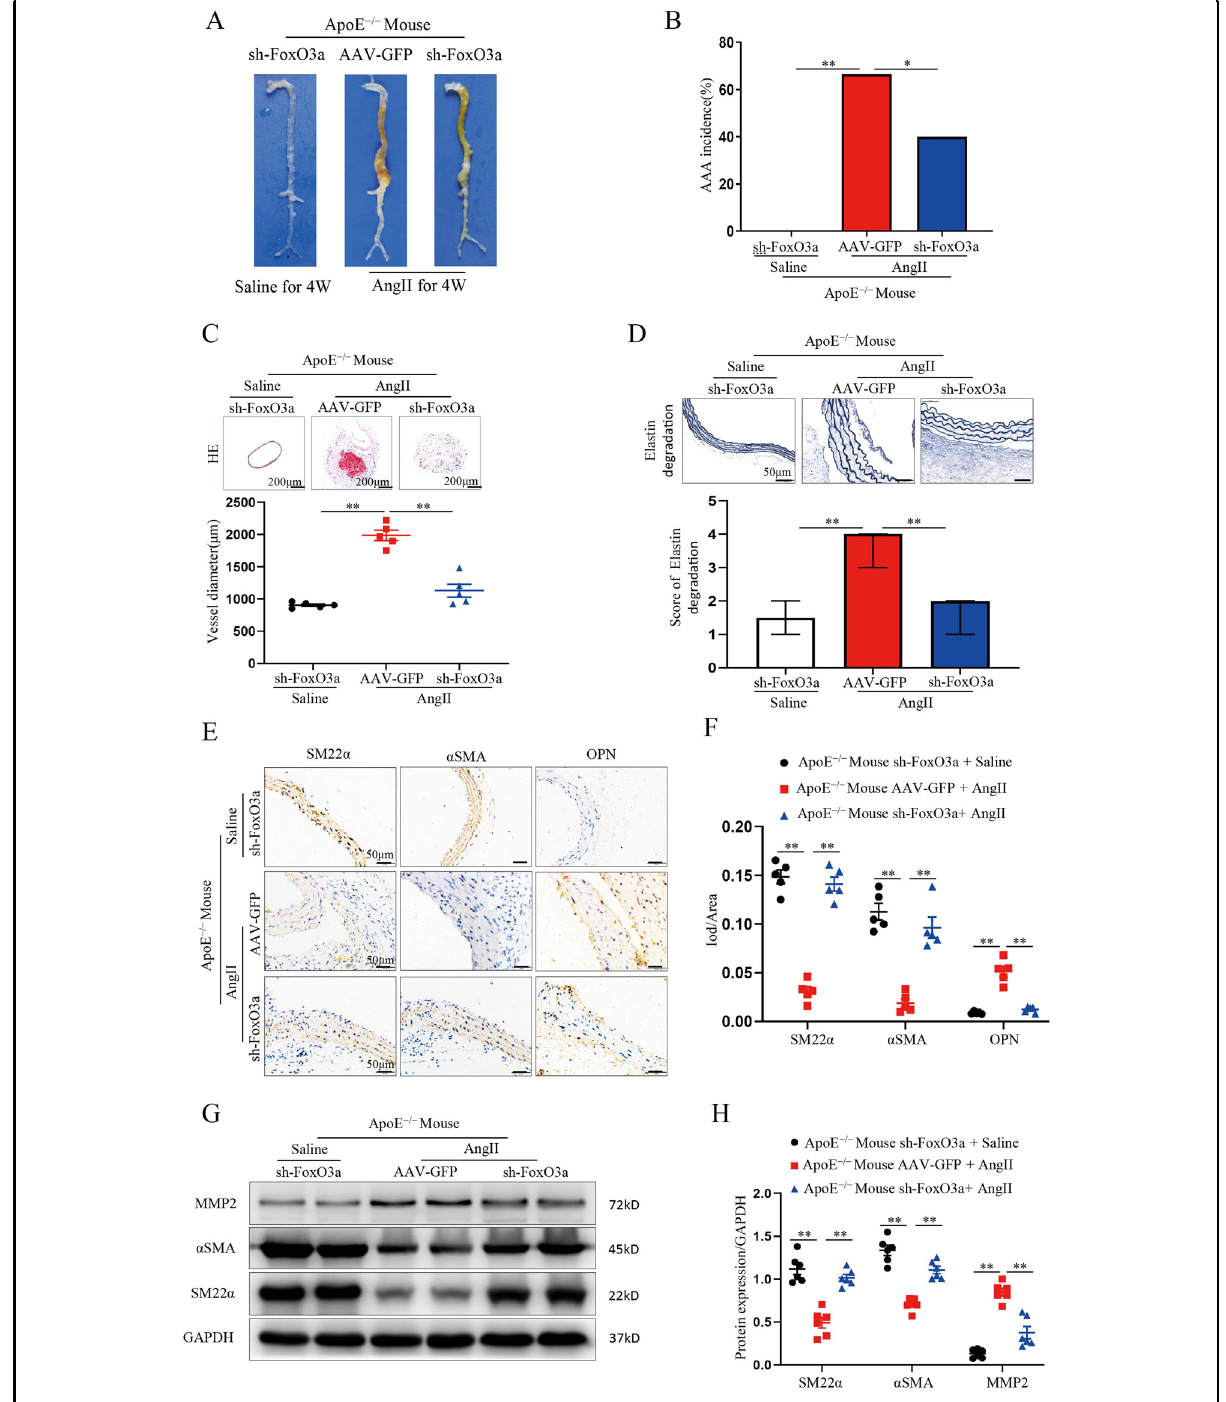
Fig. 5 FoxO3a knockdown decreased AAA formation in Ang II-infused ApoE − / − mice. Male ApoE − / − mice were treated with AAV-GFP or sh- FoxO3a, followed by infusion with saline or Ang II for 28 days. Data are presented as the mean ± SE; n = 10 in the sh-FoxO3a group (mice treated with saline), n = 30 in the AAV-GFP or sh-FoxO3a groups (mice treated with Ang II). A Representative photographs showing AAAs in all three groups. B Statistical analysis of the AAA incidence in ApoE − / − mice. C Hematoxylin-eosin staining and maximal diameter in the abdominal region ( n = 5). D Representative staining with elastin in the abdominal aortas in the three groups of ApoE − / − mice. Photographs show the location where the most severe elastin degradation occurred (scale bars, 50 µm; magni fi ed photographs n = 15). E and F Representative staining of the SM22 α , α -SMA and OPN proteins (scale bars, 50 µm, n = 5). G and H WBs and densitometric analysis of aortic MMP2, α -SMA and SM22 α ( n = 6). Data are presented as the mean ± SE. * p < 0.05, ** p <